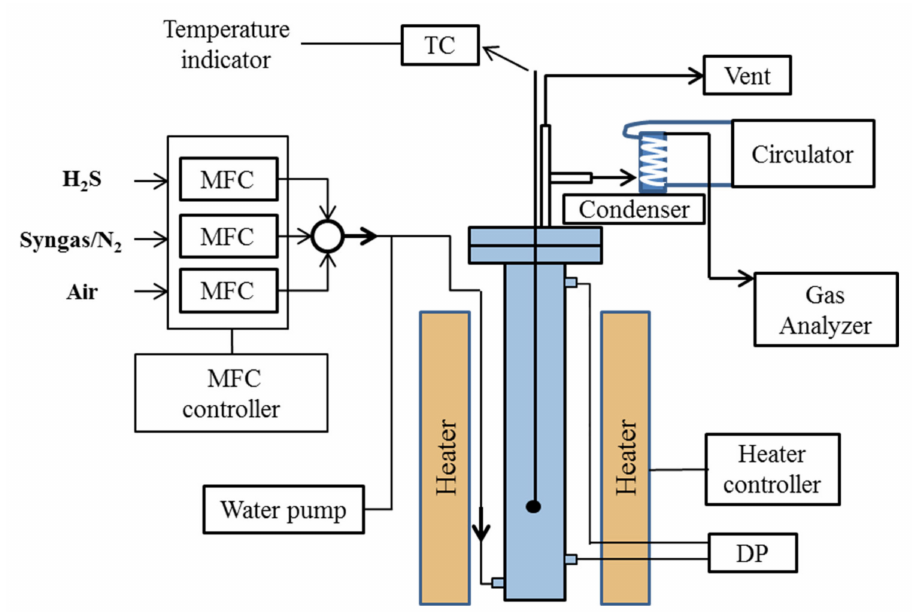
Figure 7. Schematic diagram of the experimental setup used with a batch type fluidized bed reactor for the HGD